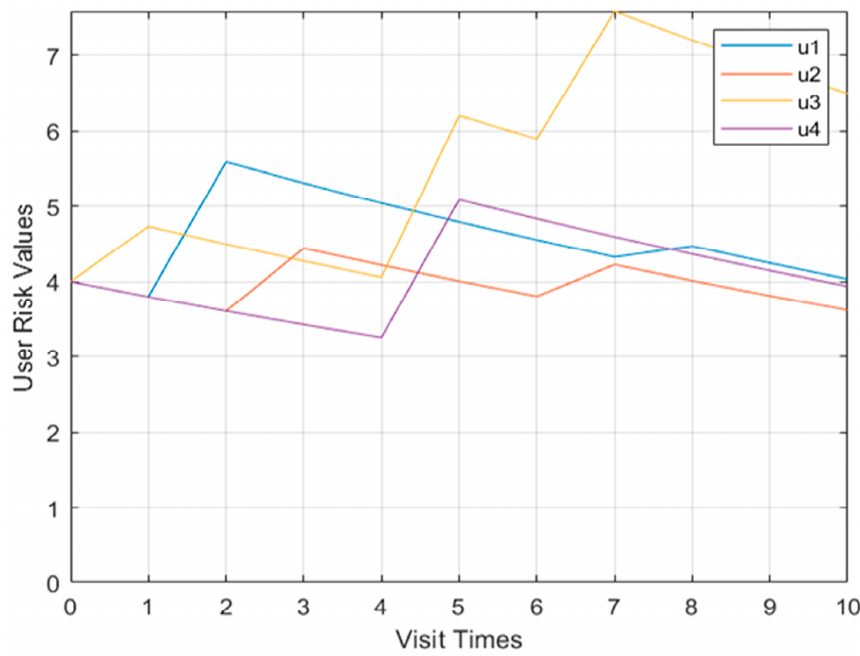
Figure 6. Model multi-user behavior risk value change curve. Shown in Figure 7 is the curve graph of the Model 1 multi-user user trust degree. When four users perform operations in violation of regulations, the user trust value does not change